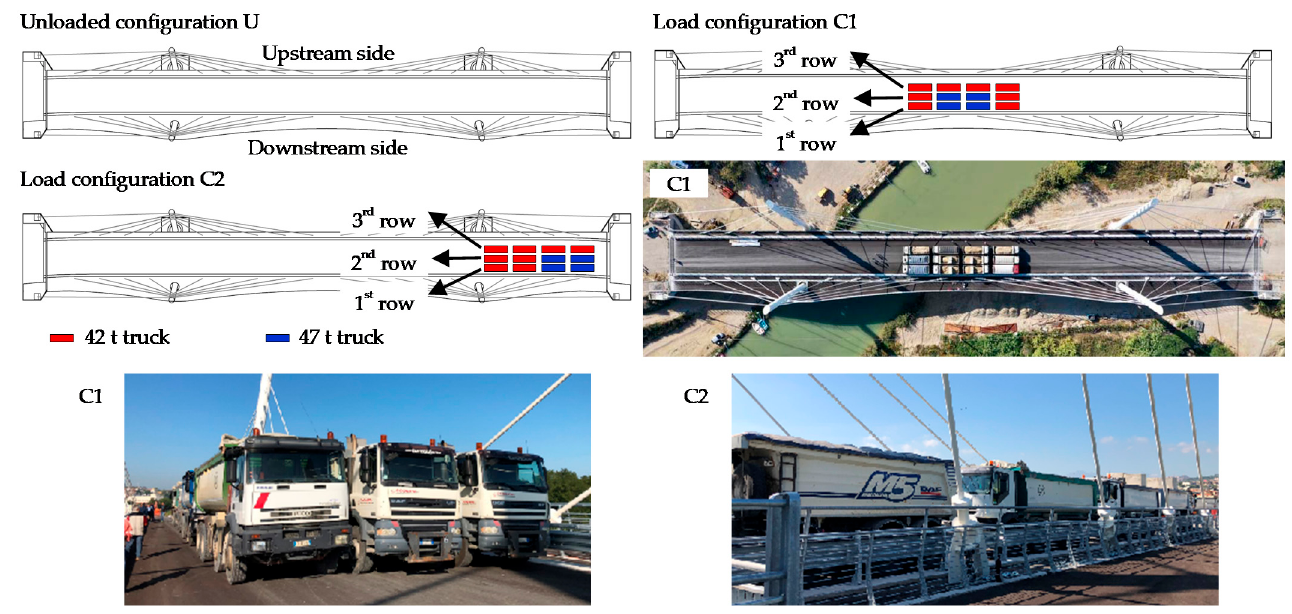
Figure 3. Schemes of proof load test configurations and relevant pictures. Table 1. Loading application phases.